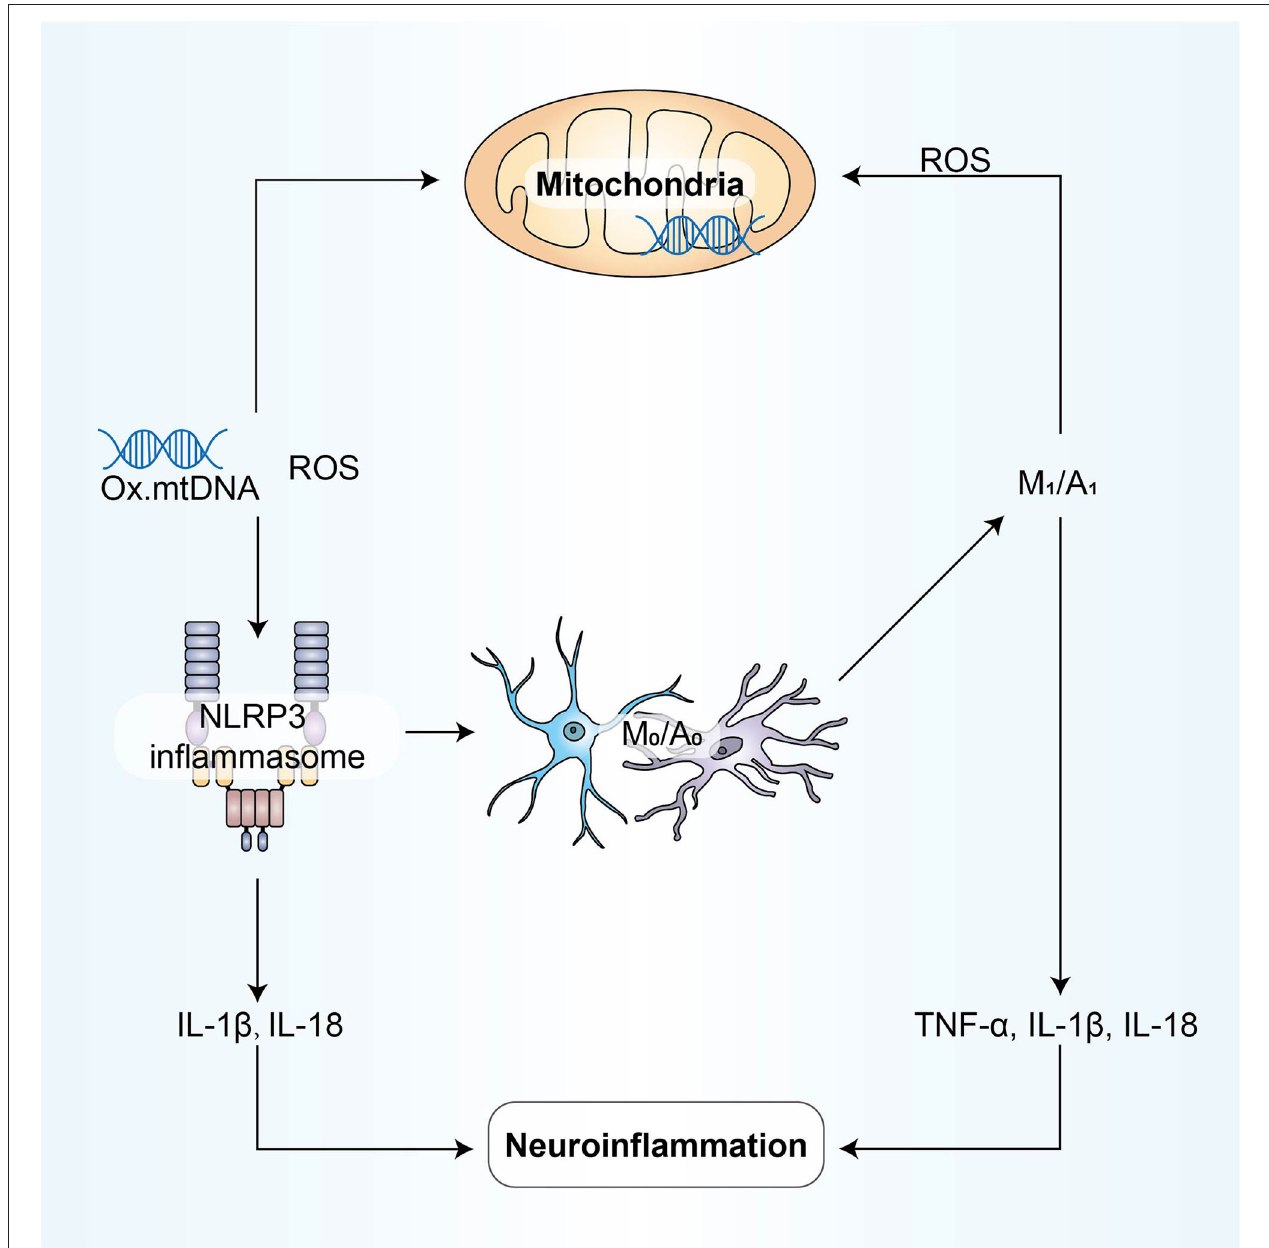
FIGURE 4 | NLRP3 activation is involved in disrupting the pro-inflammatory and anti-inflammatory balance between microglia and astrocytes; M1/A1 type cells produce and release ROS and inflammatory factors, aggravating oxidative stress and mitochondrial dysfunction; due to mitochondrial dysfunction, mtROS produced by mitochondrial respiratory chain inhibition can activate NLRP3. Inflammatory mediators play a bridging role in these processes above, and all mechanisms eventually participate in neuroinflammation directly through the form of inflammatory mediators.